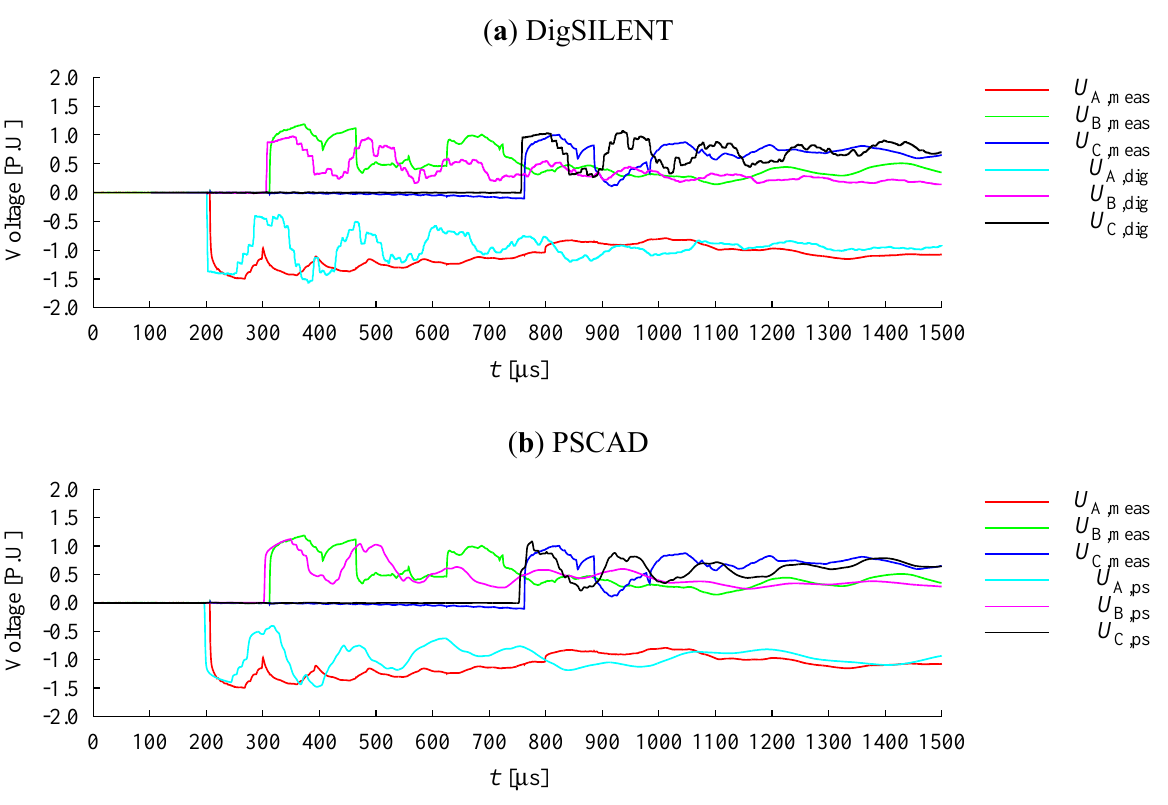
Figure 3. Comparison of measured phase voltages at A9 with simulation results in DigSILENT ( a ) and PSCAD ( b